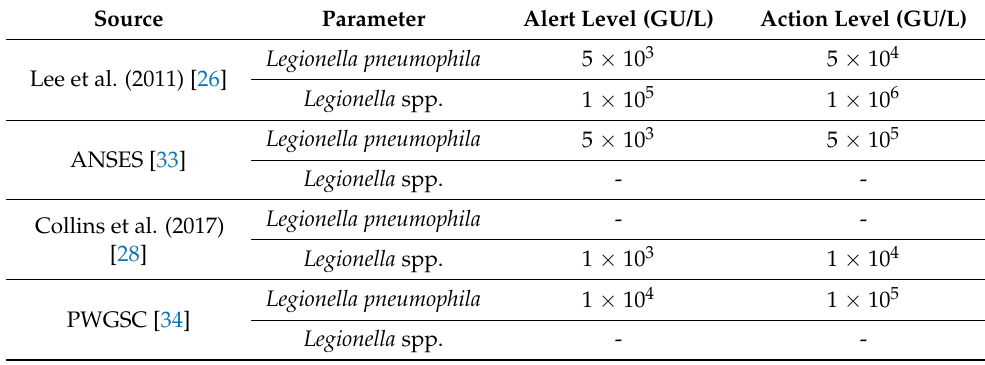
Table 5. Table to show proposed cooling tower Legionella qPCR action and alert levels from pub- lished